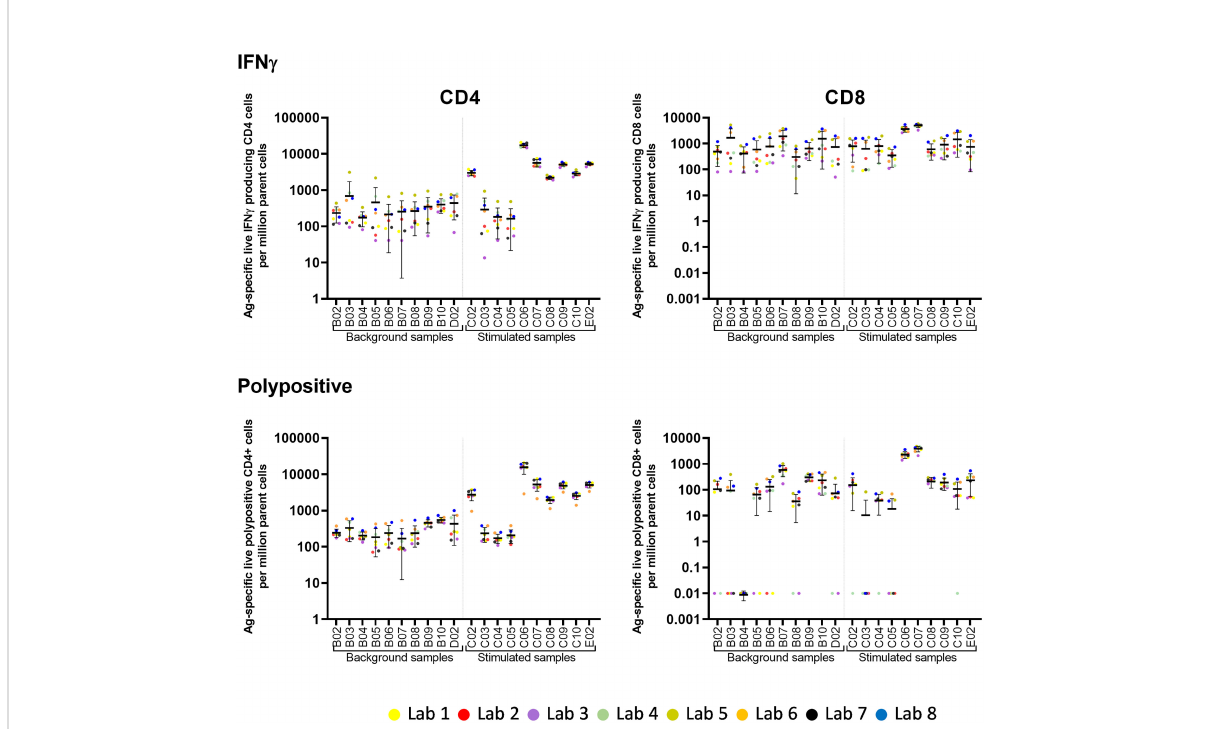
FIGURE 2 Pilot Study 2: Variability of post-analytical analysis between laboratories. Eight laboratories participated in pilot study 2. Each laboratory analyzed fcs fi les from 10 unstimulated (background) and 10 stimulated samples (x-axis). Each dot represents the number of Ag-speci fi c live IFN g or polypositive CD4 + or CD8 + cells per million parent cells from one laboratory. The horizontal line with error bars indicate the mean +/- standard deviation per sample. IFN, interferon; PP, polypositive.